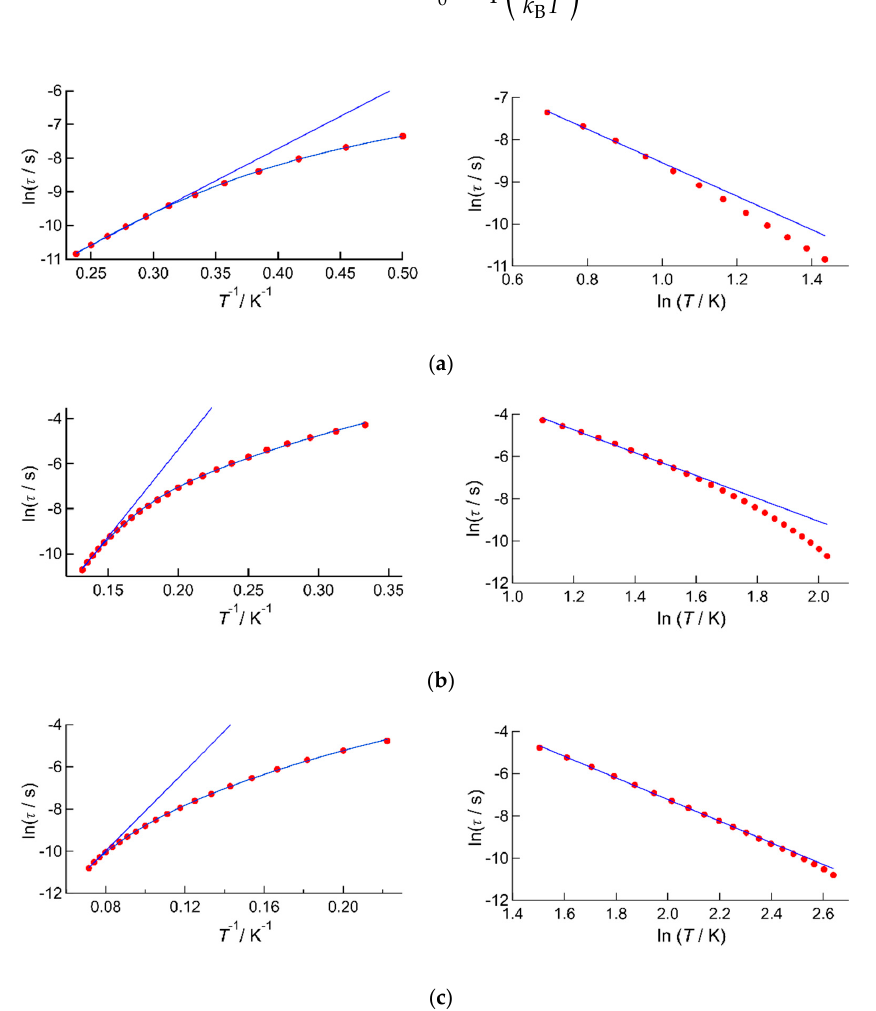
Figure 7. Temperature dependence of the flipping time of magnetization τ measured for ( a ) 1 , ( b ) 2 , and ( c ) 3 under an application of 1000 Oe DC field. ( left ) Arrhenius plots and ( right ) ln( τ ) vs. ln( T) plots. The blue lines represent theoretical calculations based on the linear Arrhenius equation for the Orbach process ( left ) or based on Equation (3) for the Raman process ( right ). The blue curves represent theoretical calculations considering both Orbach and Raman processes, expressed as Equation (4).